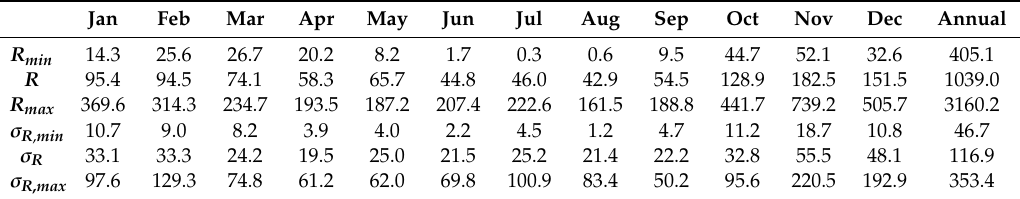
Figure 7. Annual rainfall erosivity prediction error standard deviation. Values are in MJ · mm / ha / h / y. Table 7. Mean, minimum and maximum values of erosivity R and its uncertainty σ R . Values are in MJ · mm / ha / h / month for monthly values and MJ · mm / ha / h / y for annual. Min is an abbreviation for minimum and max for maximum